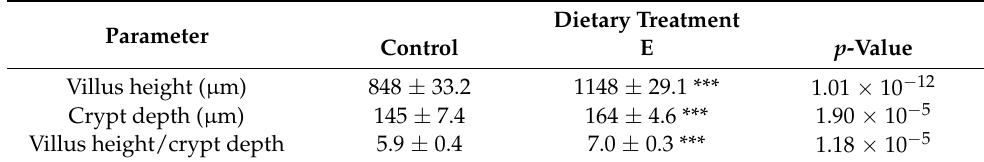
Table 4. Measurements of the duodenal villus height and crypt depth for the control and experimen- tal